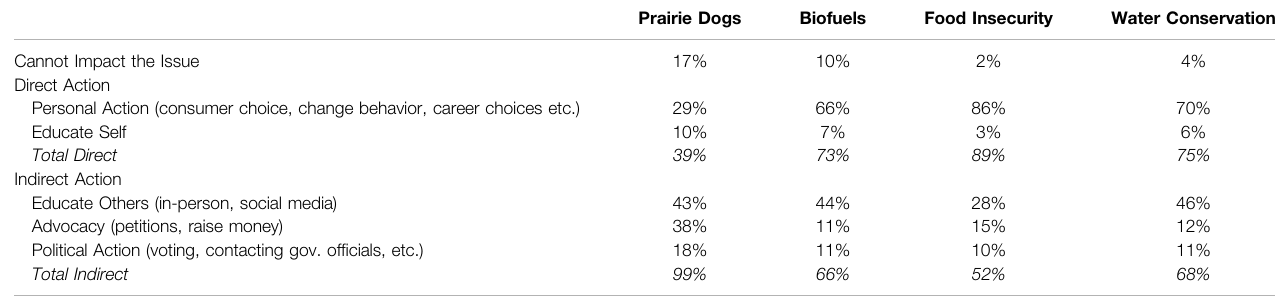
TABLE2| Studentresponsesto “ Self-Ef fi cacy ” prompt: “ Isthereanythingyoucoulddotoimpactthisissue?Whataresomethingsyoucoulddoandhowmighttheyimpact the issue? ” The % of students who responded in each coding category for each topic. Some students reported multiple behaviors (i.e., educating and voting) therefore each column sums to greater than 100% ( n (cid:1) 145). Prairie Dogs Cannot Impact the